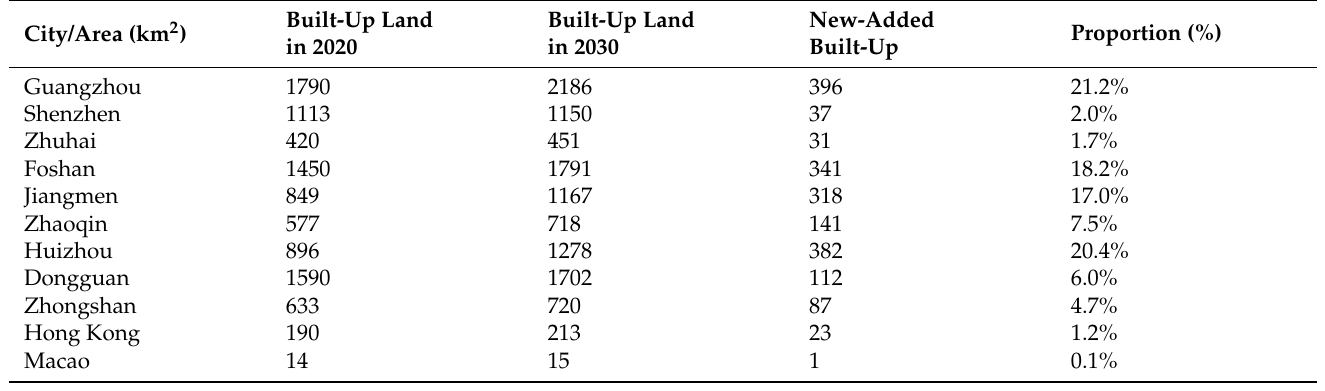
Table 4. Quantity structure of the GBA in 2030.